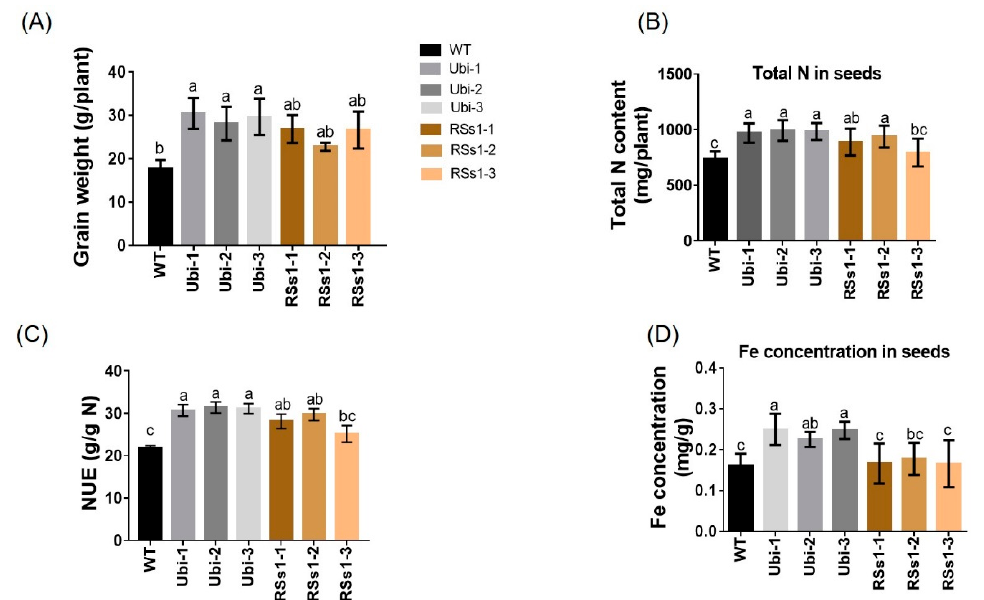
Figure 3. Characterization of barley plants in pot experiments at maturity. ( A ) Grain weight, ( B ) total N contents in seeds, ( C ) nitrogen use efficiency (NUE), and ( D ) Fe concentration in seeds. Different letters indicate a significant difference between transgenic lines and WT ( p < 0.05, one ‐ way ANOVA). Error bars: standard error ( n = 4 plants).